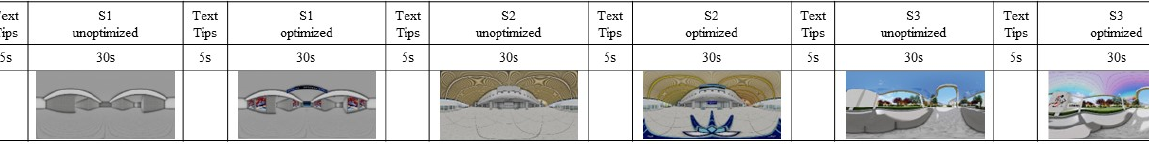
Figure 4. Experiment 3 process.